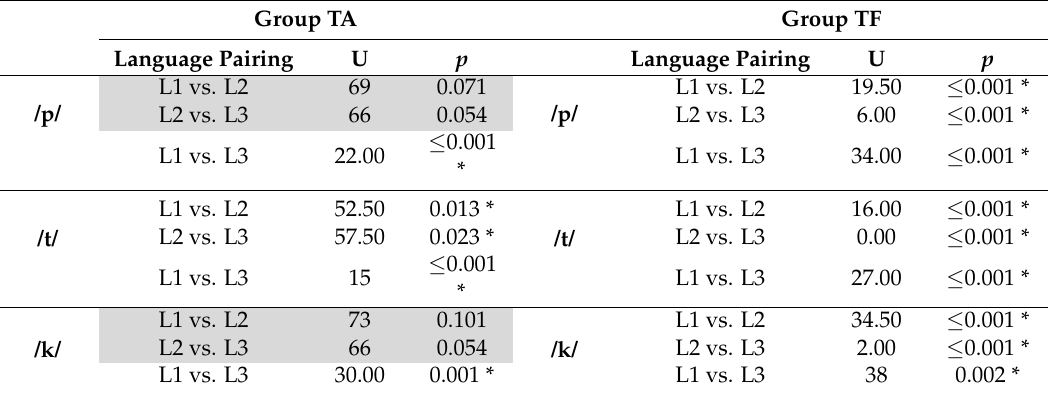
*: Asterisks indicate statistical significance. Grey shading: Grey-shaded cells contain language pairs for which no significant difference was found (see footnote